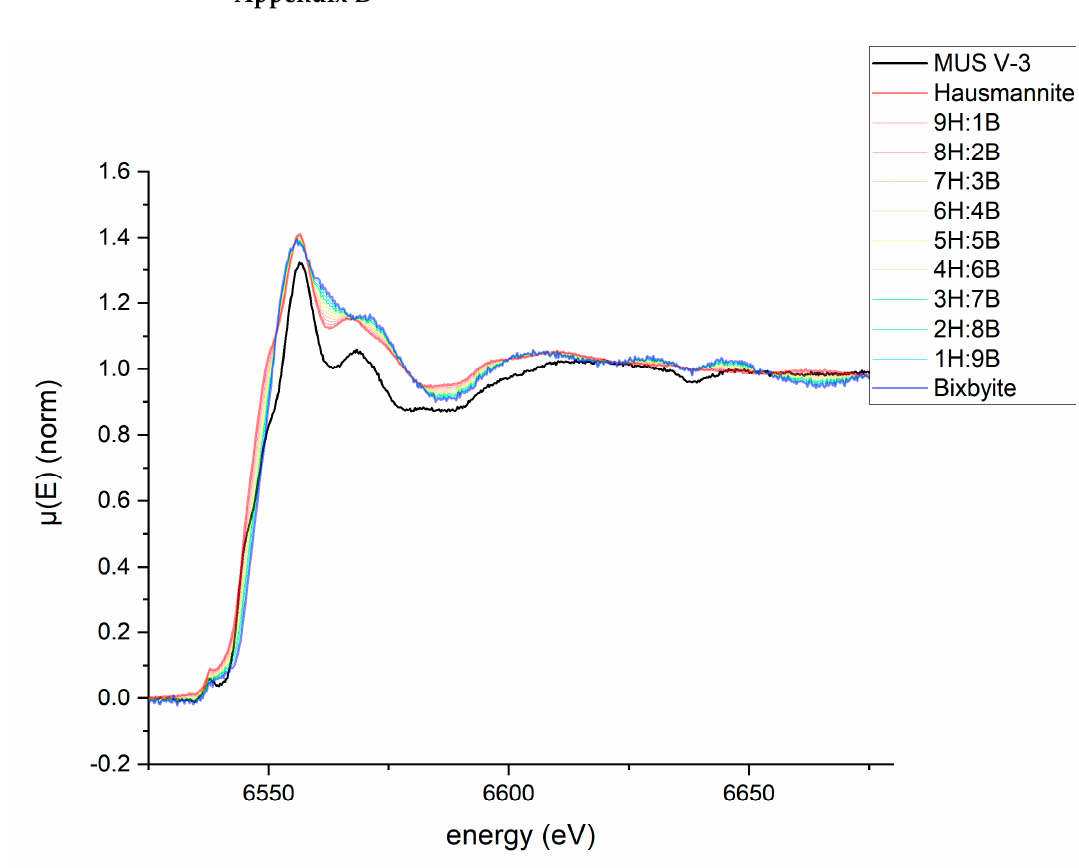
Figure A2. Close-up of Figure 4 showing the lamellae region.